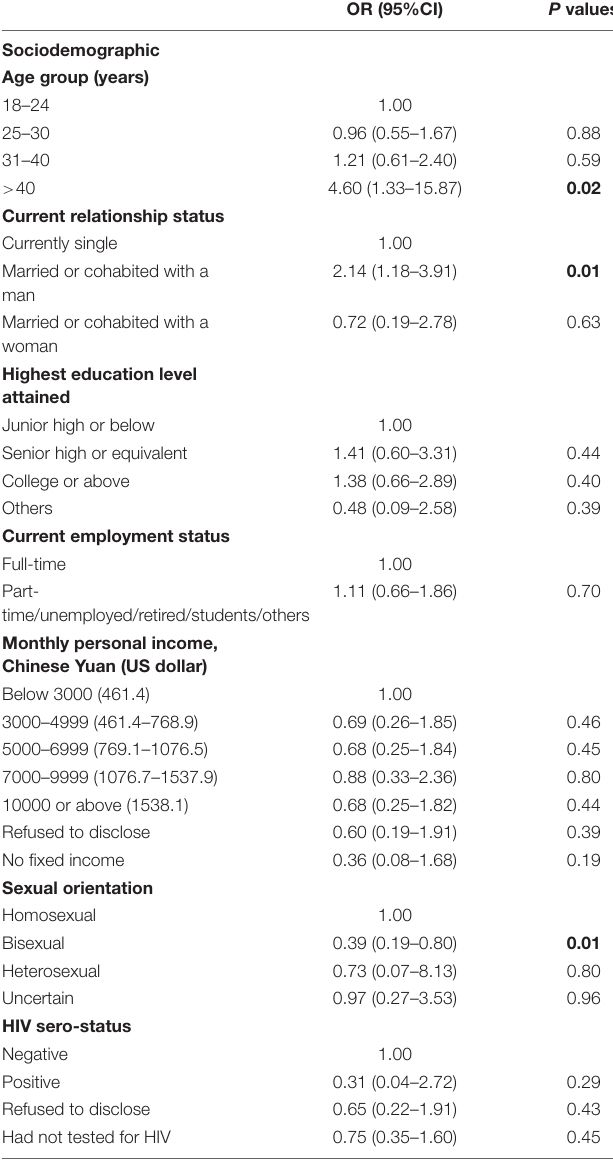
TABLE 2 | Associations between sociodemographic characteristics and uptake of COVID-19 vaccination (at least one dose) during the follow-up period (among participants who completed both surveys, n =